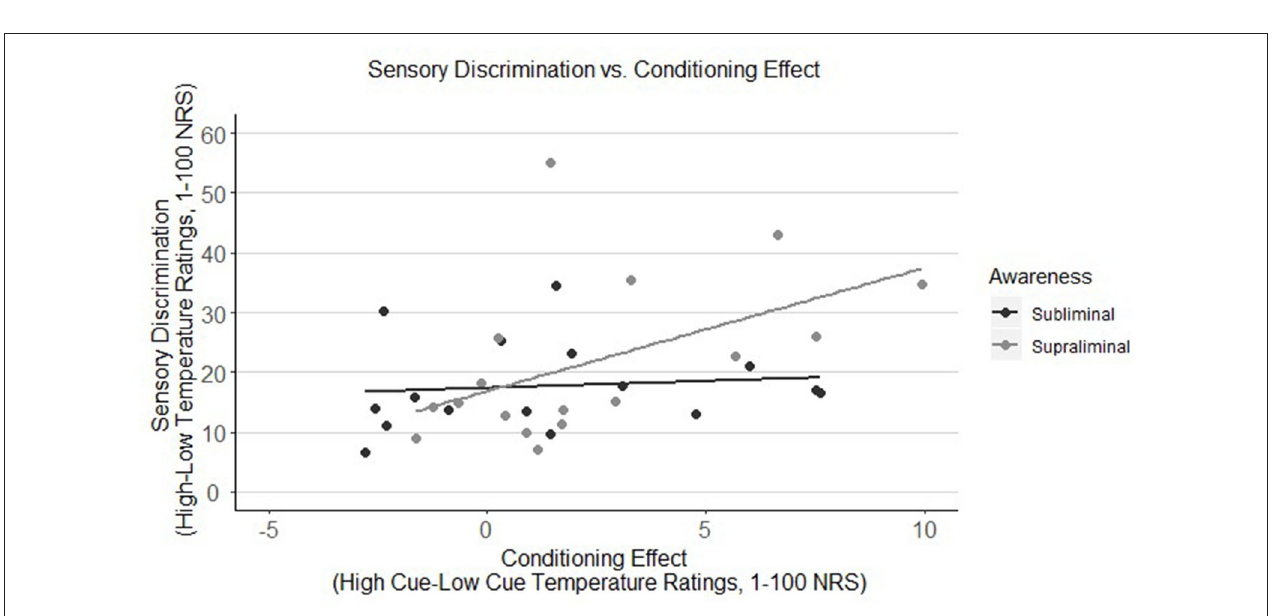
FIGURE 2 | Correlation of sensory discrimination of thermal stimuli with the conditioning effect in youth by awareness group (subliminal vs. supraliminal). Sensory discrimination is only correlated with the conditioning effect when stimuli were presented supraliminally ( r = 0.50, p = 0.039), meaning that adolescents in this group who were better able to differentiate between high and low heat stimuli, showed a higher conditioning effect. Adolescents in the subliminal group, however, did not show this relationship ( r = 0.11, p = 0.691). NRS, numeric response